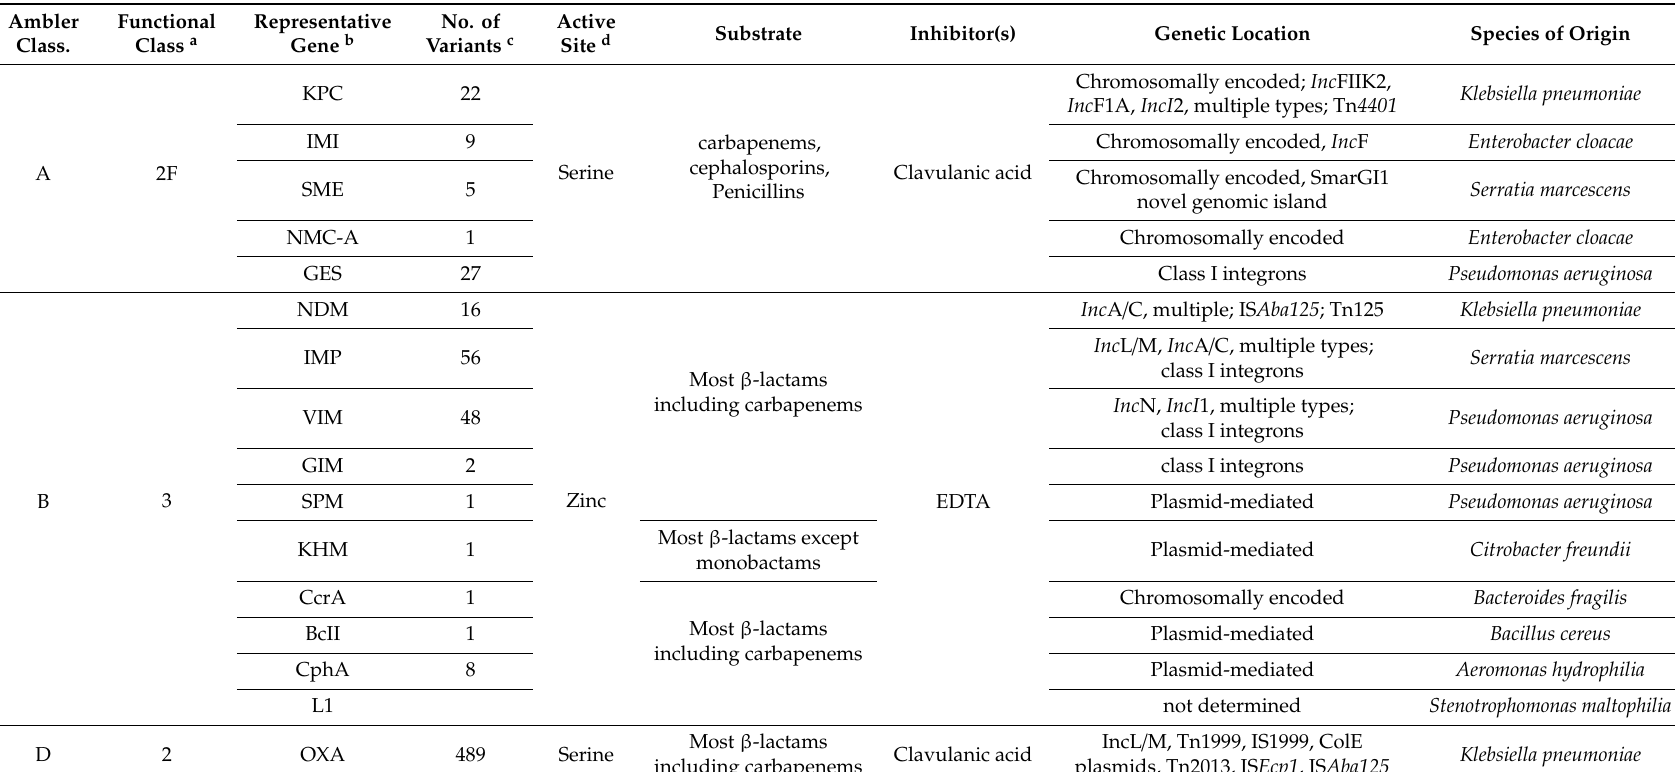
Table 1. Characteristics of the three most common classes of carbapenemases in Enterobacteriales. Ambler